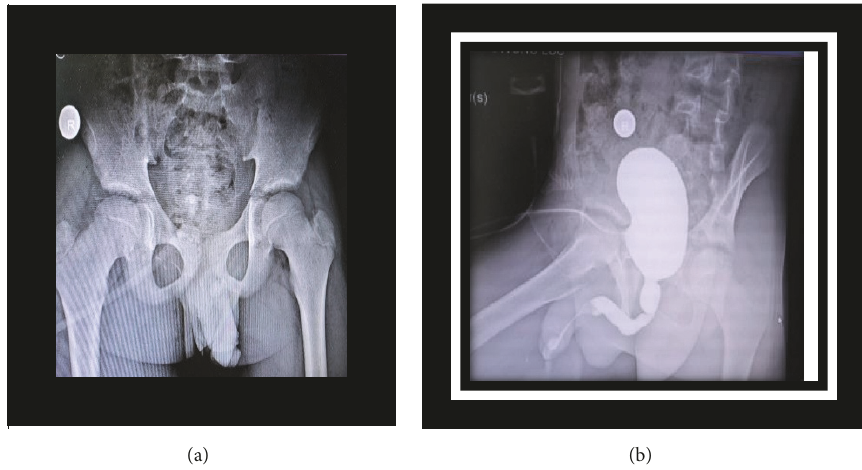
Figure 12: (a) Scout film showing penile stone (case 3). (b) VCUG, interruption of contrast (case 3).